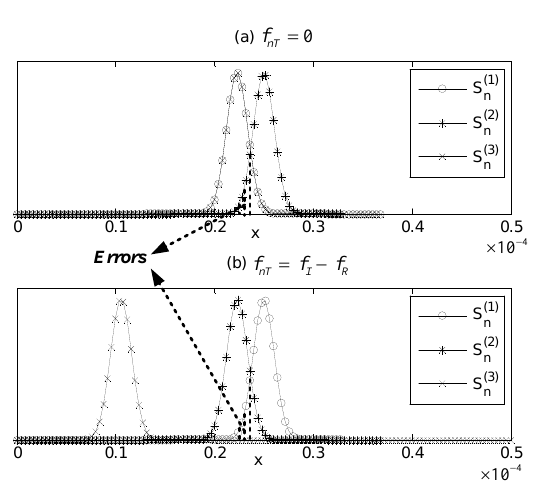
Figure 7. The PDF curves for S (1) n , S (2) n and S (3) n with (a) f nT = f I and (b) f nT = f I − f R , respectively, and γ = 8